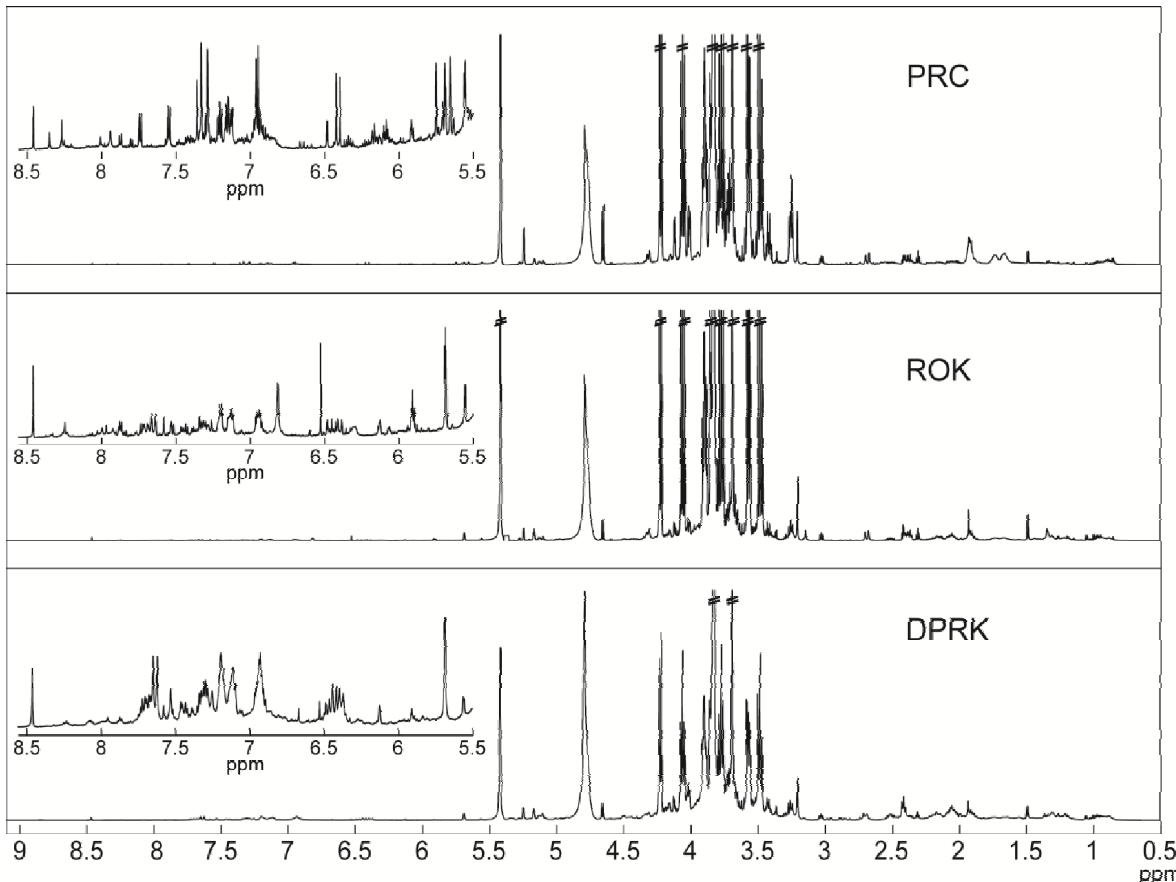
Figure 1. Average 1 H-NMR Spectra of three Angelica extracts, A. sinensis from China (PRC) and A. gigas from ROK and DPRK. Spectra represented the mean of five replicates. By visual inspection, the average 1 H-NMR spectra of the three herbs showed a very similar profile, but observable differences in the finer details. The most intense peaks were found between 3.3–4 ppm, which are associated with carbohydrates. A visible difference in peak pattern was also found between 5.5–8.5 ppm, associated with aromatic